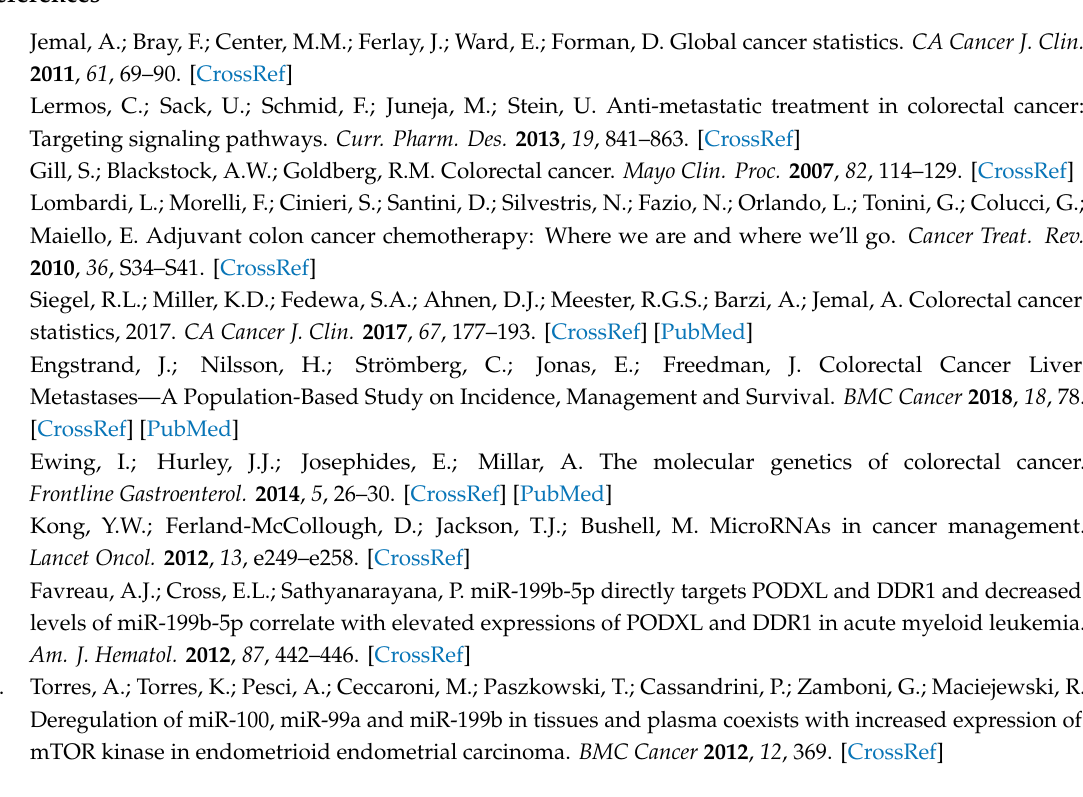
Figure S1: Clinical impact of miR-199b over time to metastasis. Figure S2: Kaplan–Meier analyses for miR-199b expression in the cohort of 157 CRC cases stratified by stage. Figure S3: Clinical significance of SET in the cohort of 157 early-stage CRC patients. (a) Immunohistochemical images of SET in LARC patients representing low, medium, and high staining. The line shows 25 µ m. Original magnification 400 × . (b) Kaplan–Meier analyses for SET expression in early-stage CRC patients. Table S1: Clinical and molecular characteristics of a series of 171 CRC patients without metastatic disease at diagnosis. Table S2: Association between miR-199b and progression (local or distant) in 171 stage I–III CRC patients. Table S3: Univariate and multivariate Cox analyses in the cohort of 157 patients with early-stage